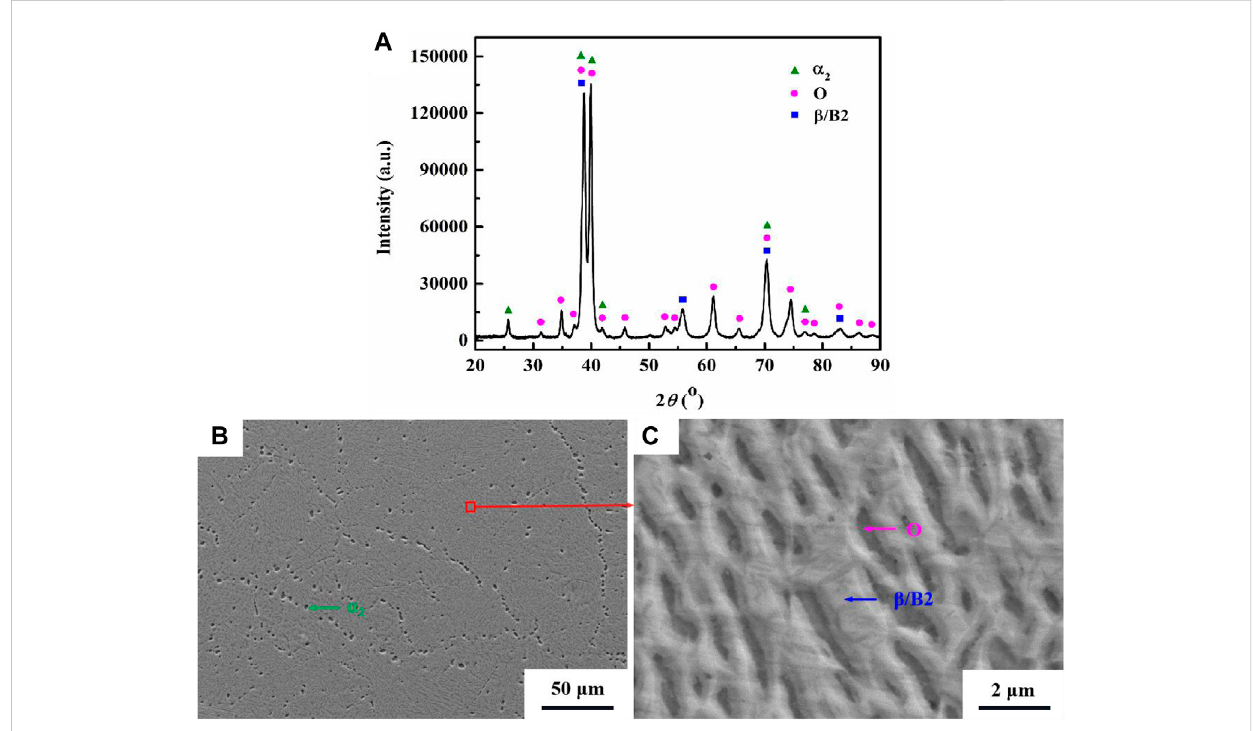
X-ray diffraction patterns of different zones in the weld joint of Ti-22Al-25Nb alloy before post-weld heat treatment: (A) fusion zone (FZ), (B) heat- affected zone